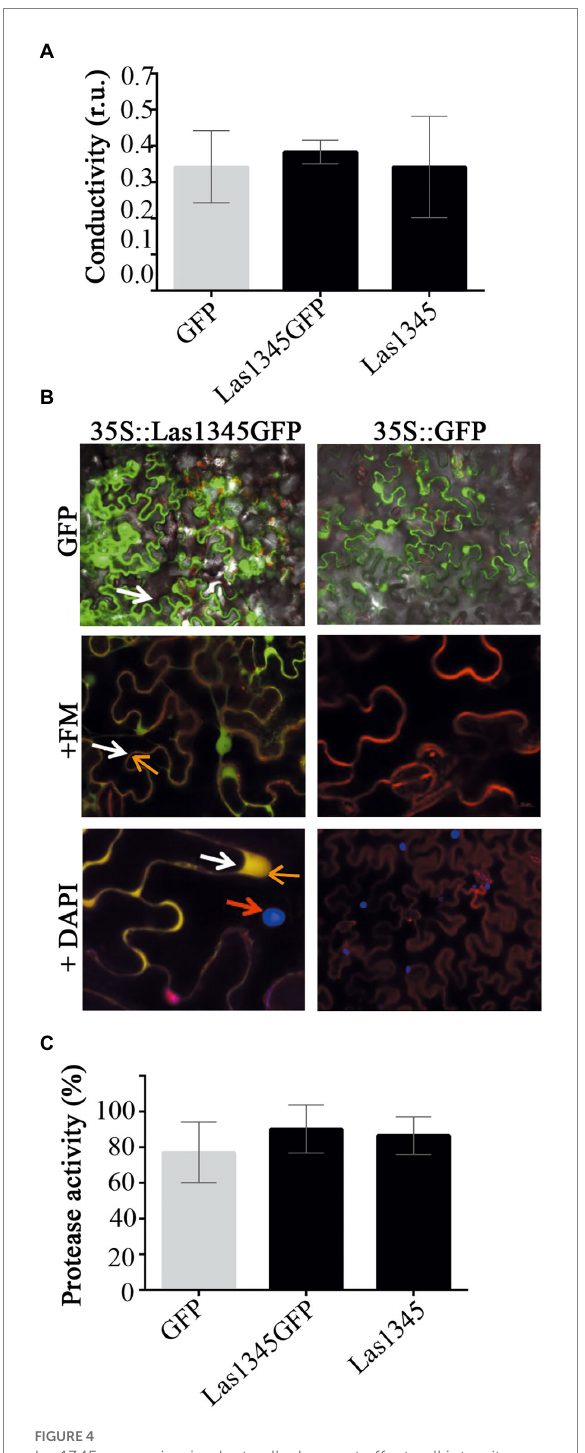
FIGURE 4 Las1345 expression in plant cells does not affect cell integrity. (A) Quantification of cell death in N. benthamiana leaves overexpressing GFP, Las1345-GFP, or Las1345 by measurement of conductivity at 3 days post agroinfiltration (dpi). Values are expressed as mean ± standard deviation of six samples. Each sample was obtained from three leaf disks of 1 cm 2 collected randomly from different agroinfiltrated leaves. Data was analyzed by two-way analysis of variance and Tukey’s test at p < 0.05.